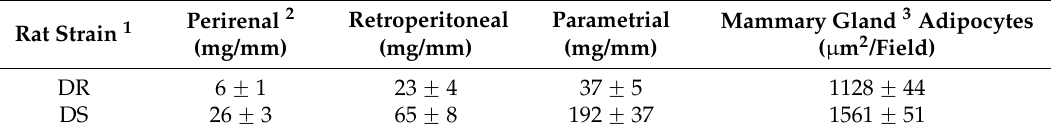
Table 1. Visceral and peripheral assessment of